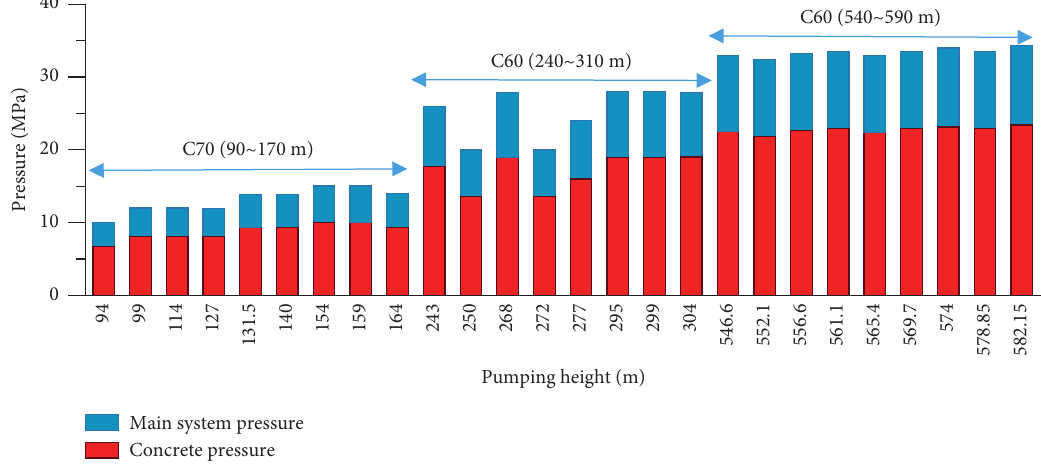
Figure 10: The change law between the pressure and the height.